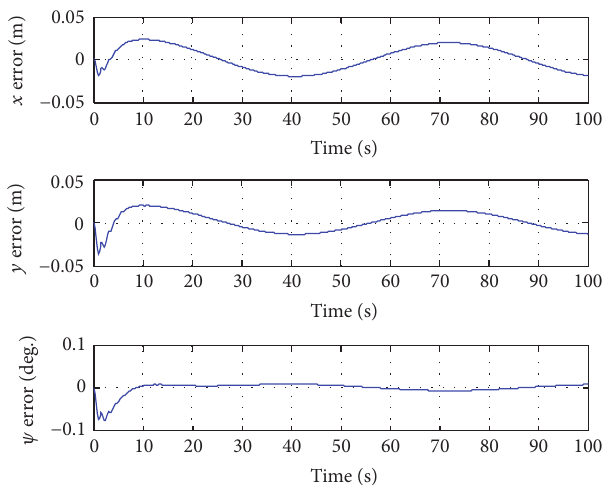
Figure 7: The position error of ship with environmental distur- bances.